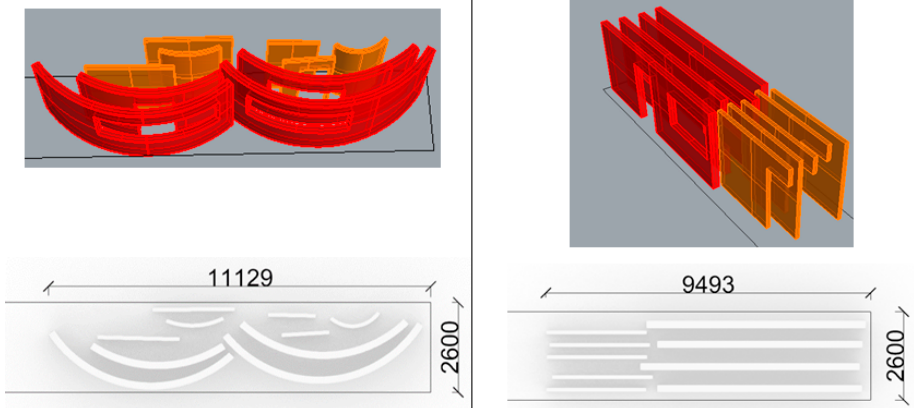
Figure 2. Transportation simulation for the house models (dimensions are in millimeters). Table 2. Project component